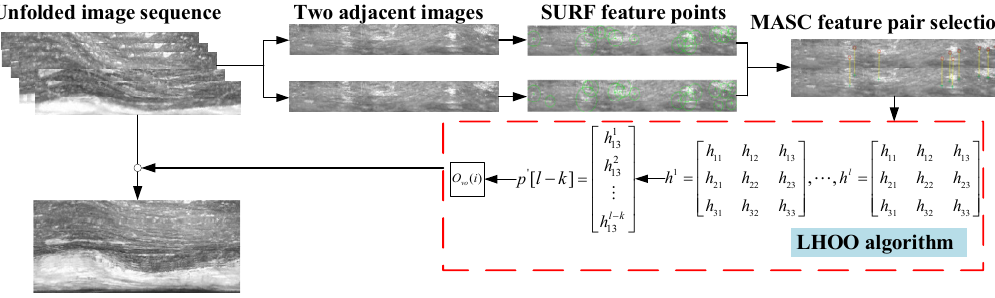
Figure 1. Flow chart of the video image stitching system.